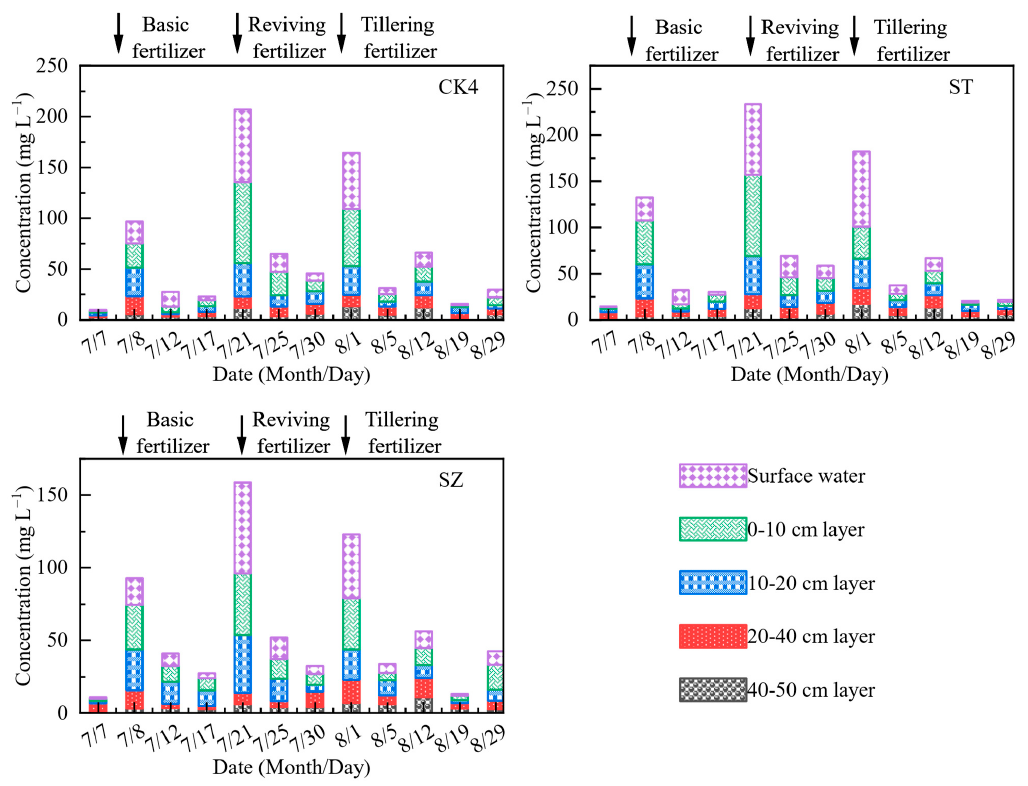
Figure 9. Dynamic changes in total nitrogen (TN) concentration in different layers of surface water and soil solutions under different treatments. Top left panel shows the no straw returning group (CK4); top right panel shows the straw returning group (ST); bottom left panel shows the straw re- turning with zeolite group (SZ). Different fertilizer treatments are indicated by black arrows.